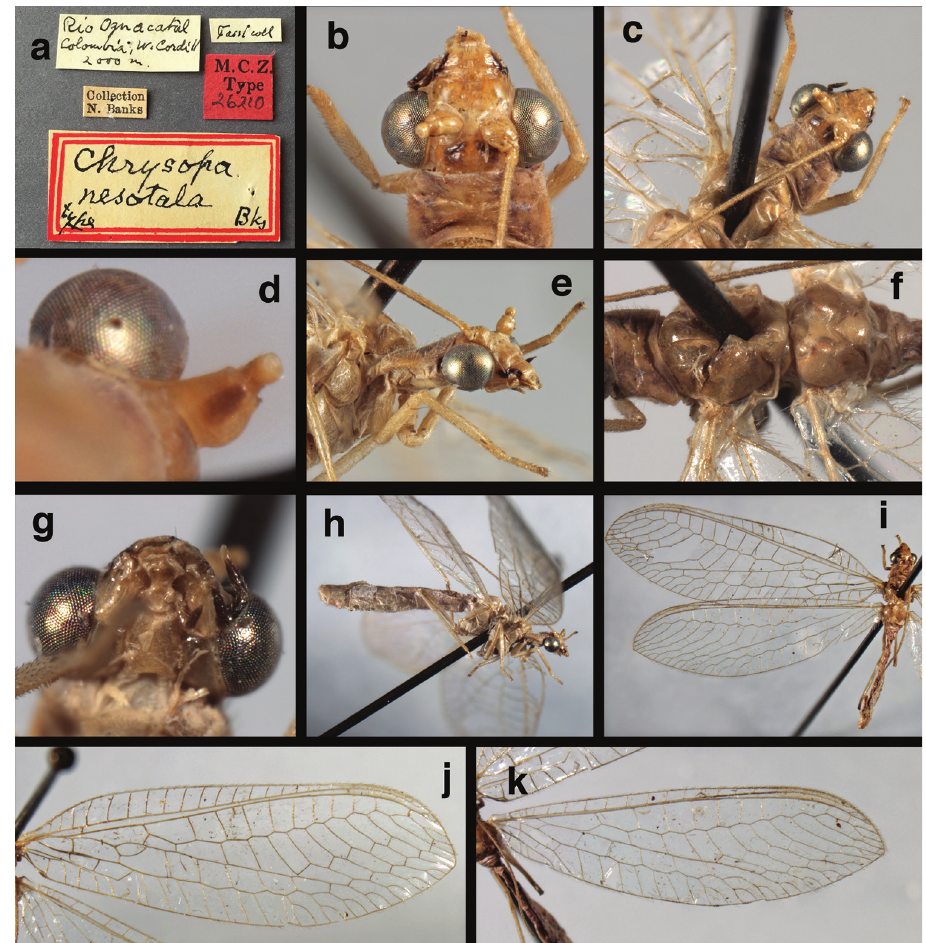
Figure 37. Chrysopa nesotala Banks: External features, ( a ) labels ( b ) head, frontodorsal ( c ) head, pro- thorax, dorsal ( d ) scape, dorsal ( e ) head, prothorax, lateral ( f ) thorax, dorsal ( g ) head, ventral ( h ) body, lateral ( i ) body, left wings ( j ) right forewing ( k ) right hindwing (Colombia, Rio Ognacatal, holotype, female,